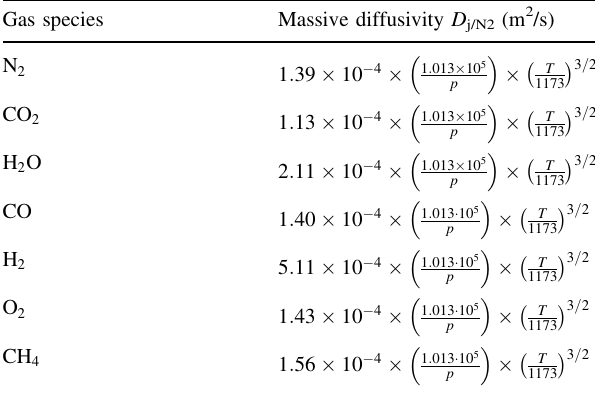
Table 15 Expression of the mass diffusivity of gaseous species as a function of temperature (Chapaman–Enskog formula) (Mermoud 2006) Gas